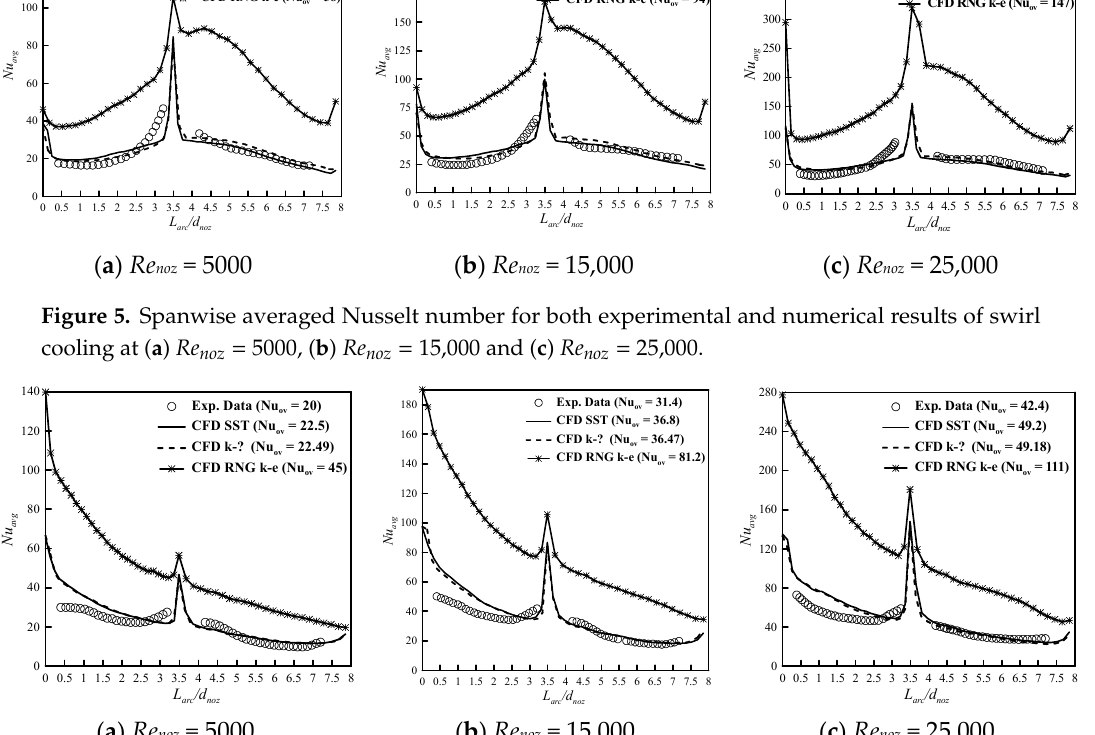
Figure 6. Spanwise averaged Nusselt number for both experimental and numerical results of impingement cooling at ( a ) Re noz = 5000, ( b ) Re noz = 15,000 and ( c ) Re noz = 25,000.